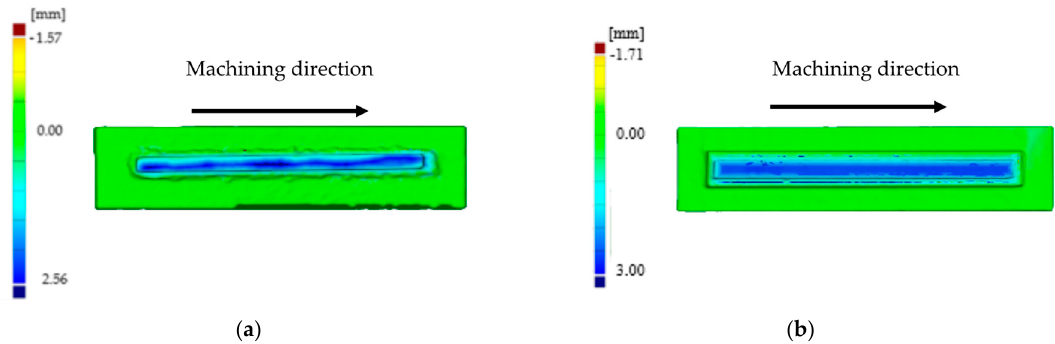
Figure 15. Axial depth of cut for the second set of experiments: ( a ) LMD-AD wall; ( b ) forged-SA wall.